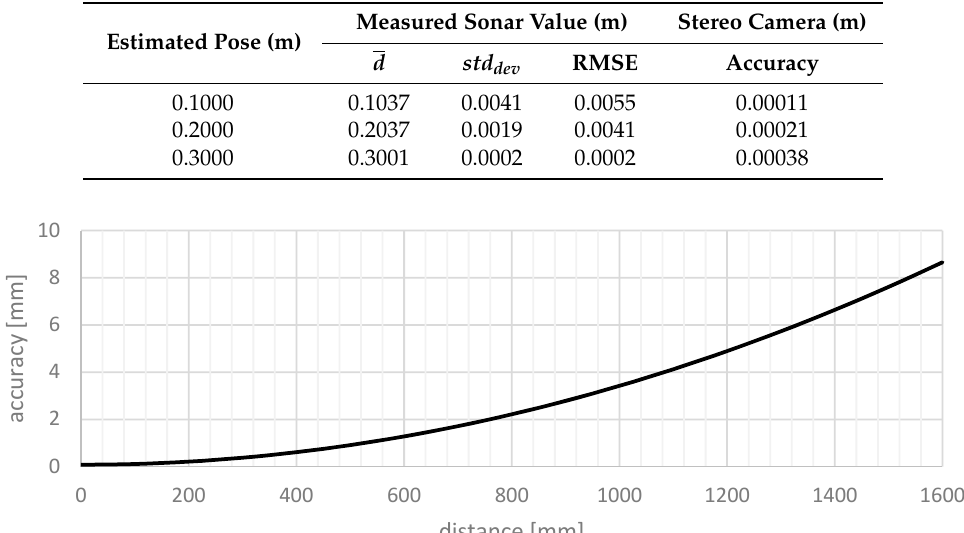
Table 2. Calibration results of the sonar sensor compared with the accuracy of a theoretical stereo camera. Estimated Pose (m)